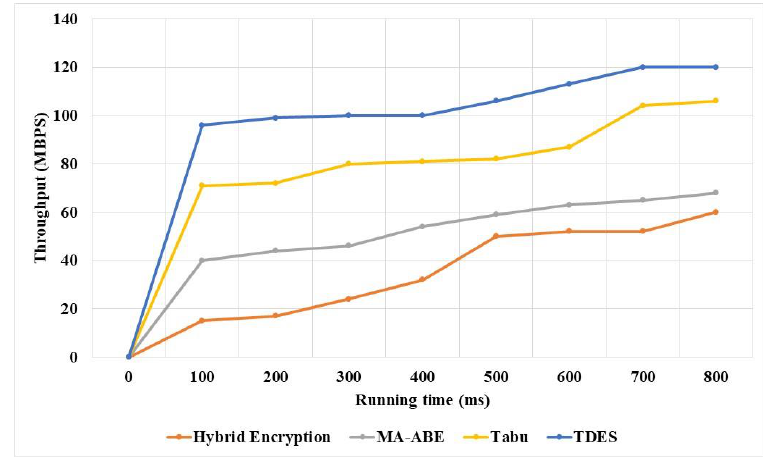
Figure 11. Throughput of TDES and existing techniques for various running times.